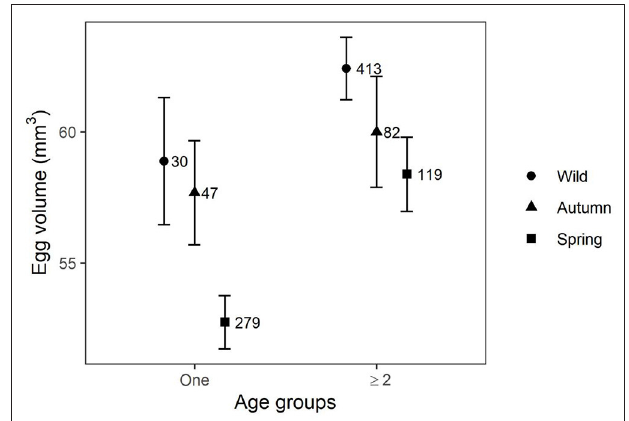
FIGURE 4 | Predictions of mean egg volume ( ± CI) for wild-born and captive-bred migrant Asian houbara ( Chlamydotis macqueenii ) released in spring and autumn from two age